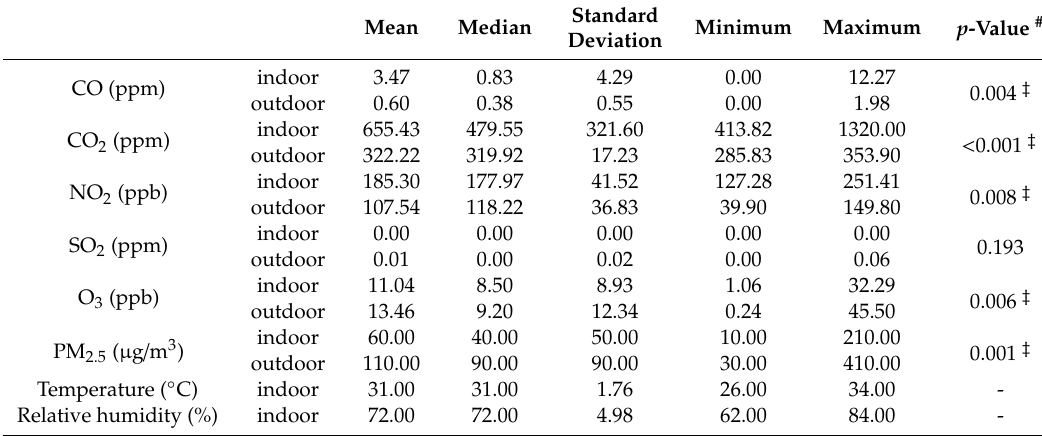
Table 1. Descriptive statistics of 24-h average indoor and outdoor air pollutants, temperature, and relative humidity in 60